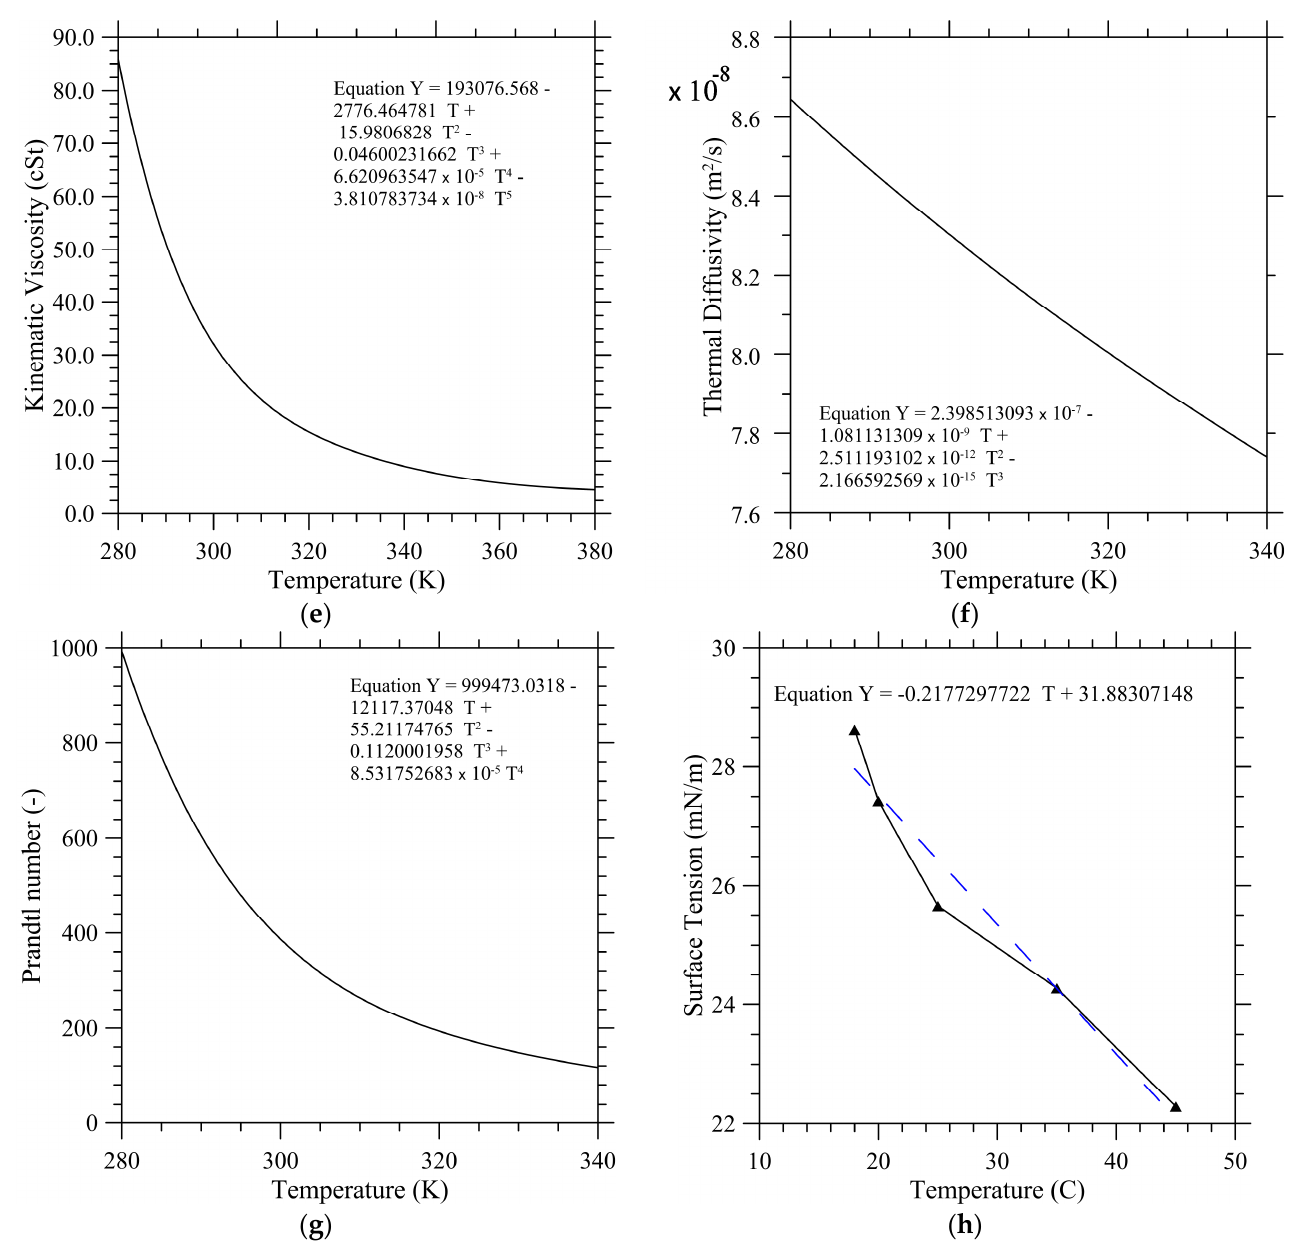
Figure 2. Physical Properties of Emkarate RL22H as a function of temperature as provided by the manufacturer: ( a ) Dynamic viscosity μ (exp. measurements); ( b ) Density ρ (exp. measurements); ( c ) Specific Heat at constant pressure C p (exp. measurements); ( d ) Thermal conductivity λ (exp. measurements); ( e ) Kinematic viscosity ν (derived quantity, ν = µ / ρ , 1 cSt = 10 − 6 m 2 /s); ( f ) Thermal diffusivity α (derived quantity, α = λ / ρ C p ); ( g ) Prandtl number (derived quantity, Pr = ν / α ), ( h ) Surface tension σ